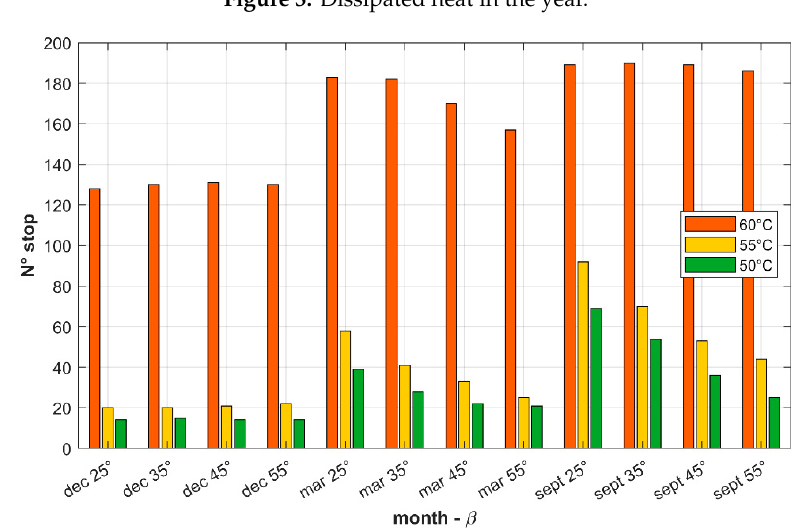
Figure 4. Number of MED stop in the year.